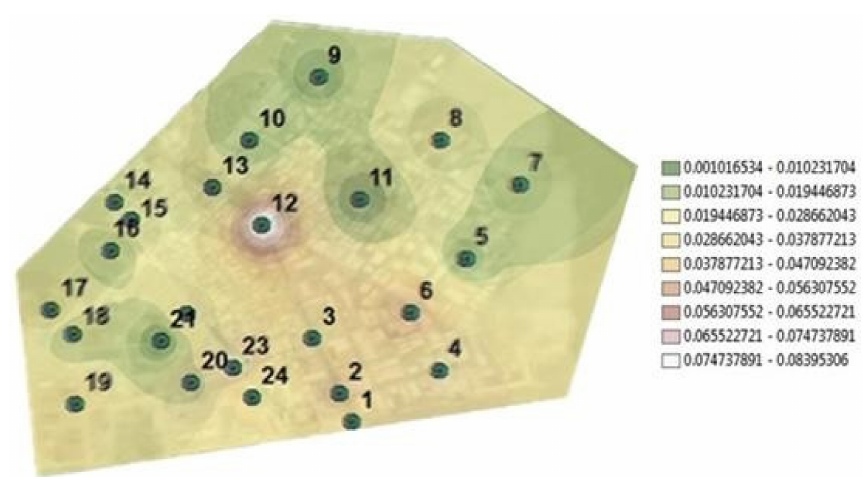
Figure 6. PM 10 average concentration ( µ g/m 3 ) distribution throughout the day.